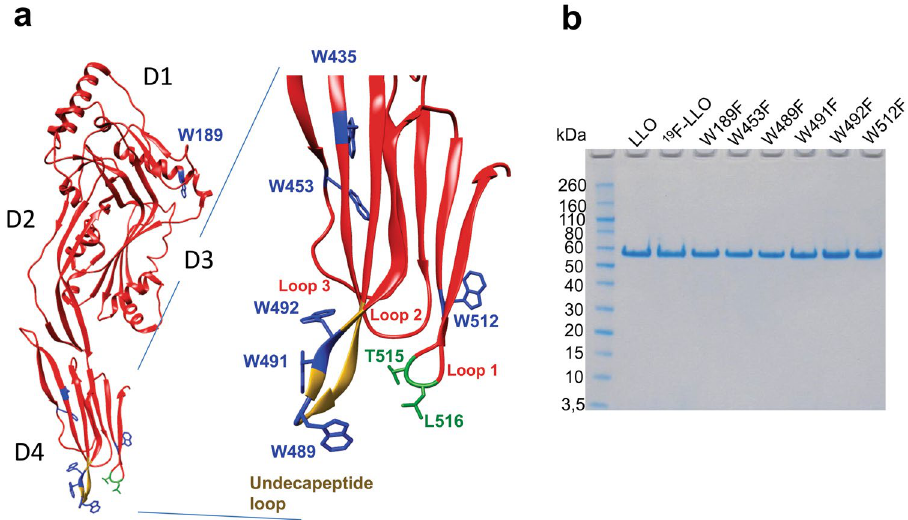
Figure 1. Structural model of LLO and purified LLO protein variants. ( a ) Structural model of LLO (PDB 4CDB) 16 . Domains 1–4 are designated D1–D4. Trp residues are designated in blue. The Chol-recognition motif in D4 is denoted in green. The inset shows enlarged D4, where relevant structural parts are labelled, and ( b ) SDS-PAGE analysis of purified LLO, 19 F-LLO and mutants employed in the